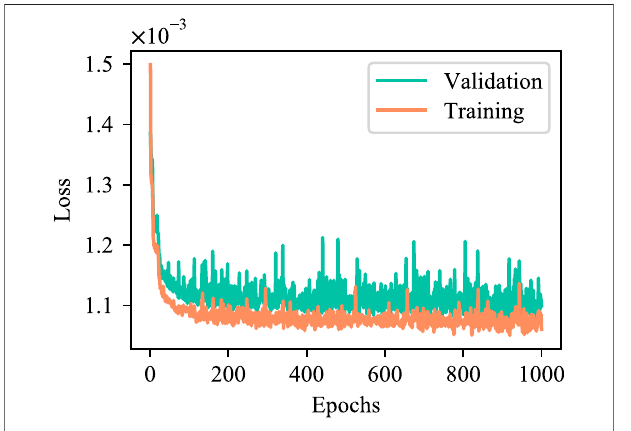
FIGURE 3 | Training and validation loss over epochs.